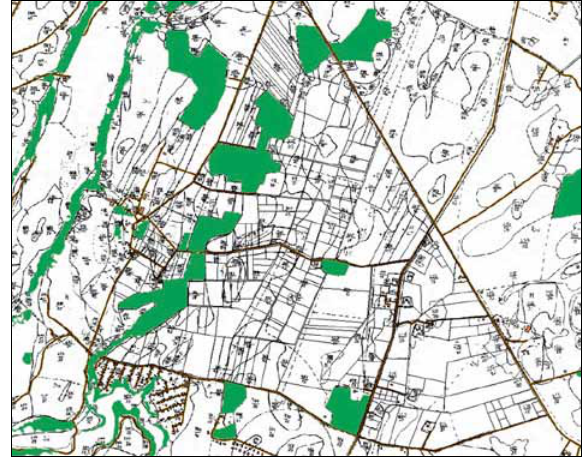
Fig. 7. Layers of all data at